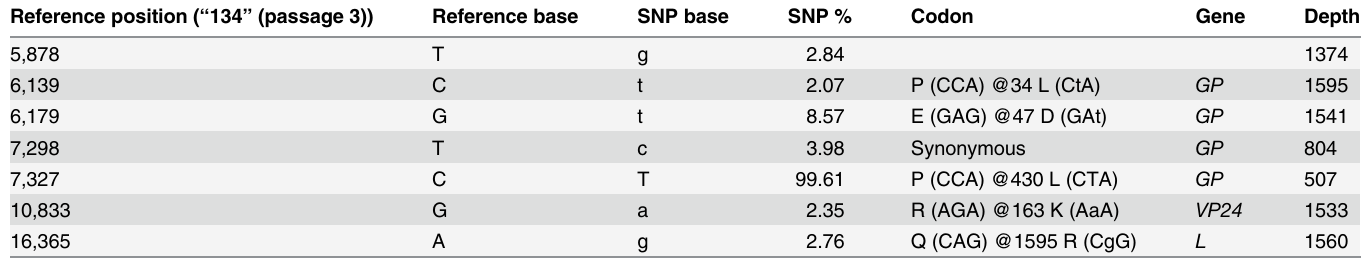
Table 1. Intrahost single nucleotide variants (iSNVs) of EBOV/Kik-9510621 “ R4368 ” (passage 4) comprising (cid:4) 2% of total population as compared to “ 134 ” (GenBank #AY354458). Reference position ( “ 134 ” (passage 3))